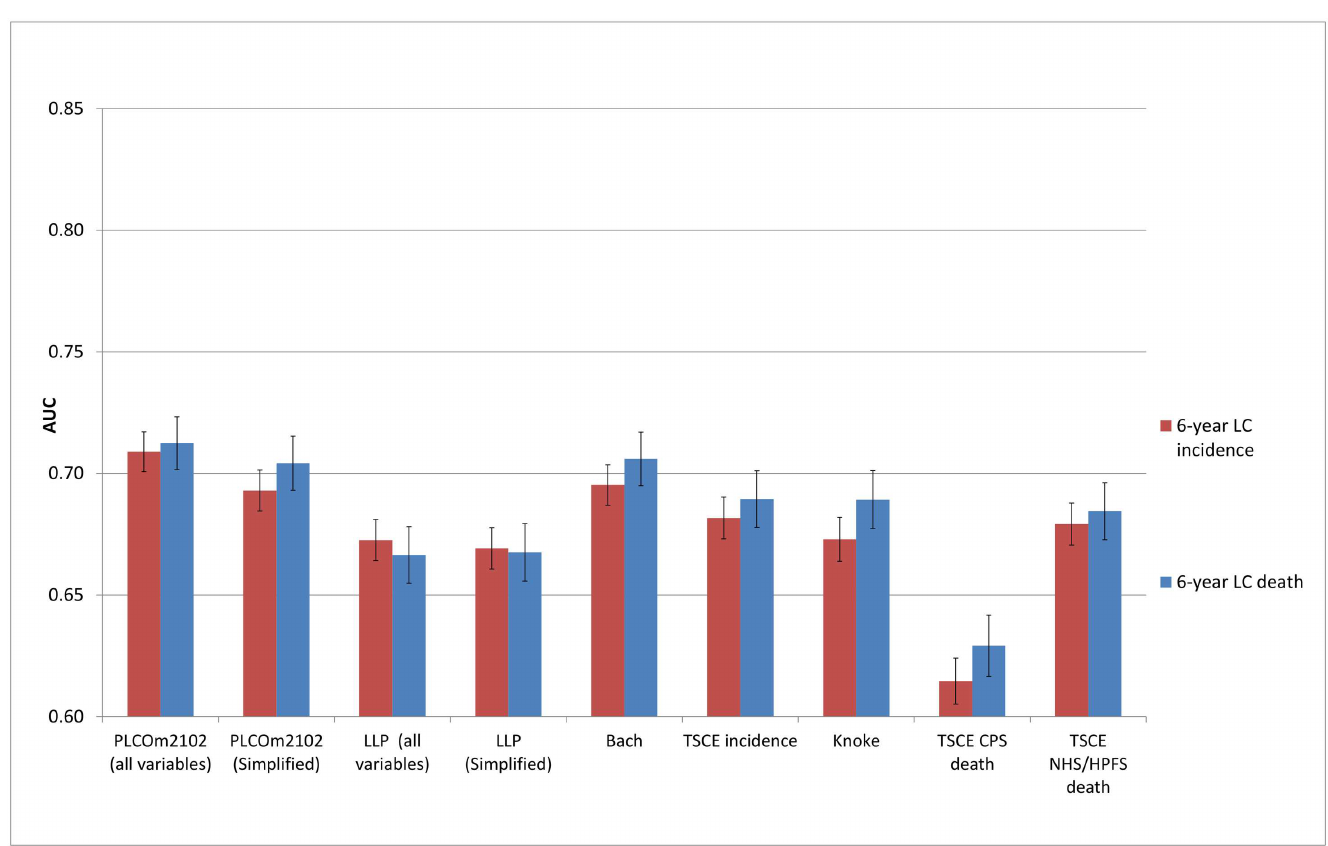
Fig 3. Area under the receiveroperating characteristic curve of the investigated risk models (with 95% confidence interval) in the National Lung Screening Trial chest radiography arm by predicted outcome. AUC, area under the receiver operatingcharacteristic curve; CPS, Cancer PreventionStudy; HPFS, Health ProfessionalsFollow-upStudy; LC, lung cancer; LLP, LiverpoolLung Project; NHS, Nurses’ Health Study; TSCE, Two- Stage